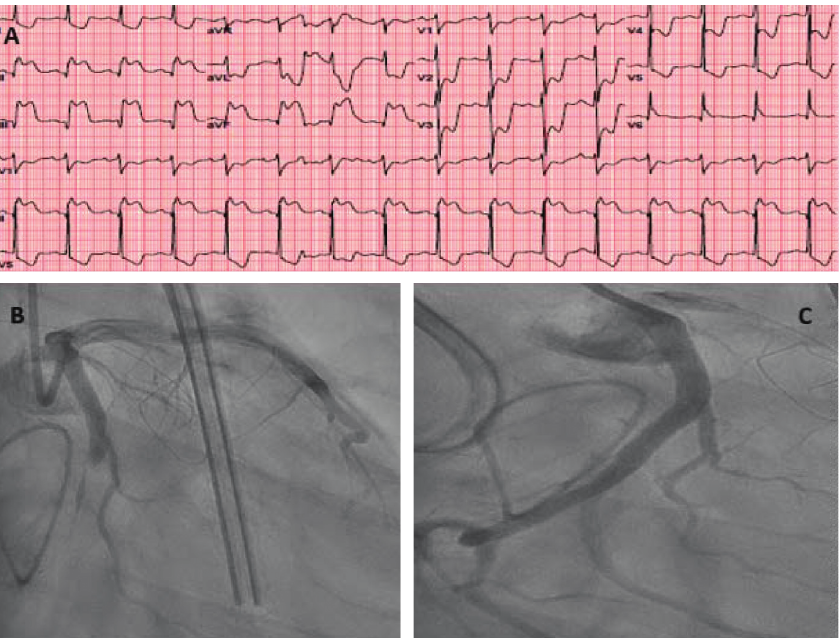
Figure 2: (a) ECG of a case with acute inferoposterior STEMI after mitral valve repair. (b) Left coronary angiogram showing CX midsegment total occlusion. (c) PCI and stenting with TIMI III.